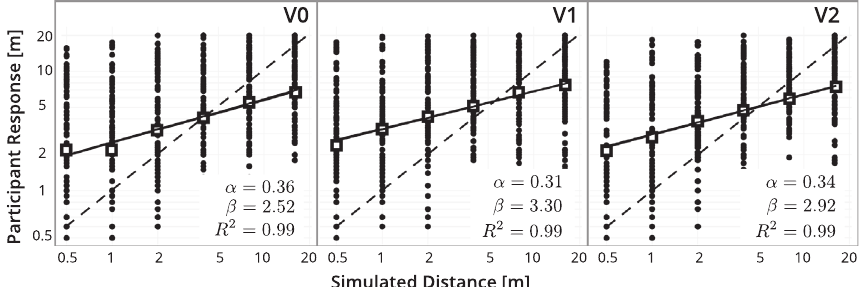
Figure 3. Perceived distances as functions of simulated distances for different familiarity levels (V0, V1, and V2). Parameters of the fi tted power functions ( a and b ) as well as coef fi cients of determination ( R 2 ) are also shown. The dashed diagonal line represents veridical distance localization (i.e. D = D